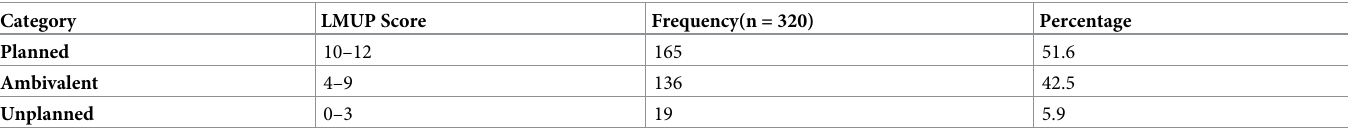
Table 3. Distribution of LMUP score by